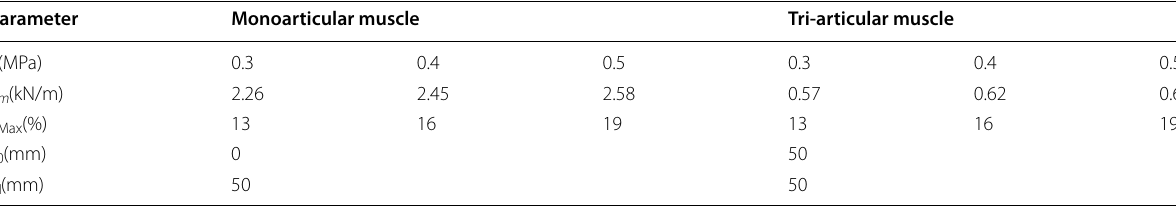
Table 2 Parameters of the McKibben artificial